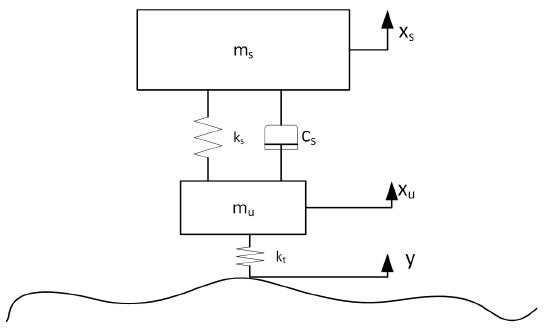
Figure 1. The QC Model.